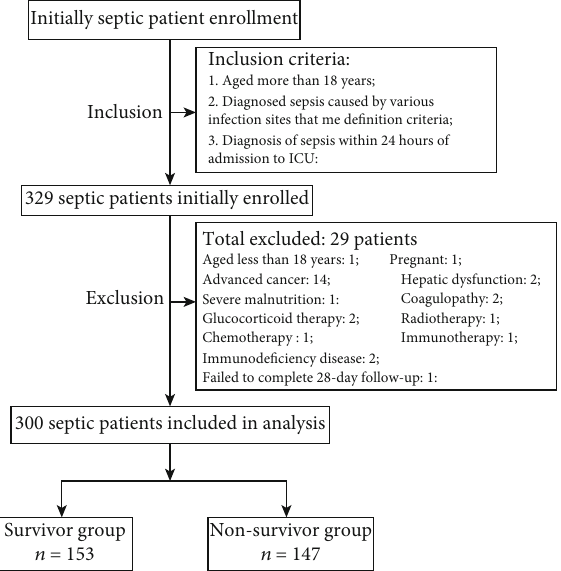
Figure 1: Flow chart of patient